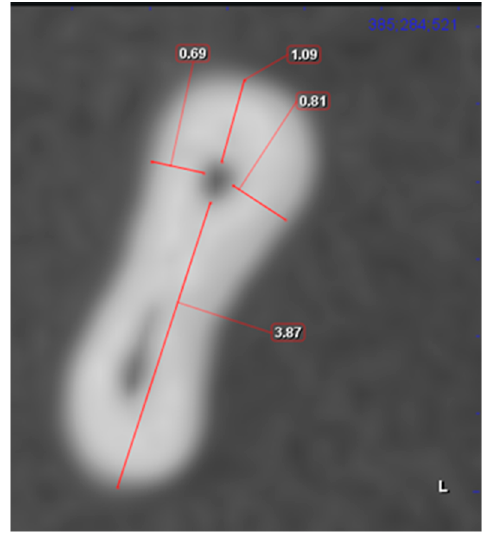
Figure 2. Measurements on CBCT scan.